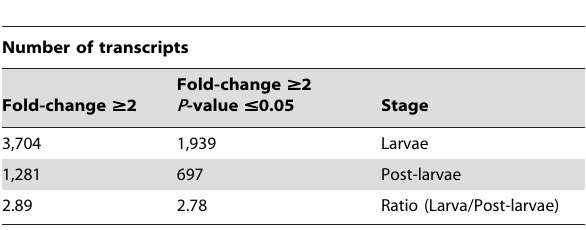
Table 1. Number of transcripts differentially represented in the M. rosenbergii developmental transcriptomic database.